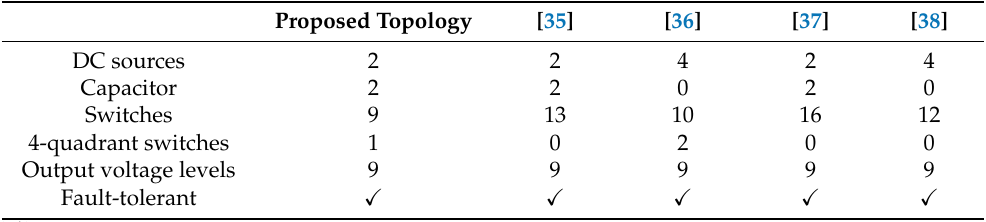
Table 6. Comparison of various parameters of the proposed FT MLI topology with other recently developed